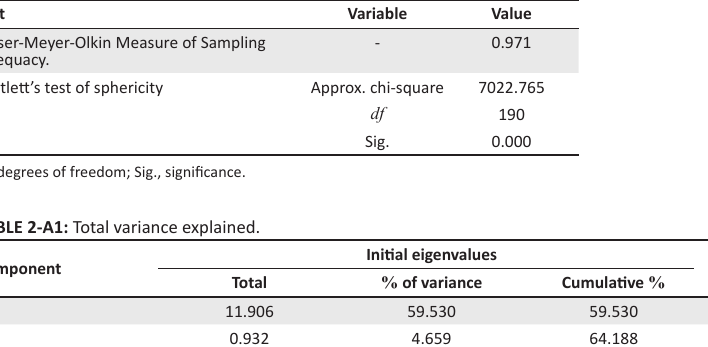
TABLE 1-A1: Kaiser-Meyer-Olkin and Bartlett’s test.